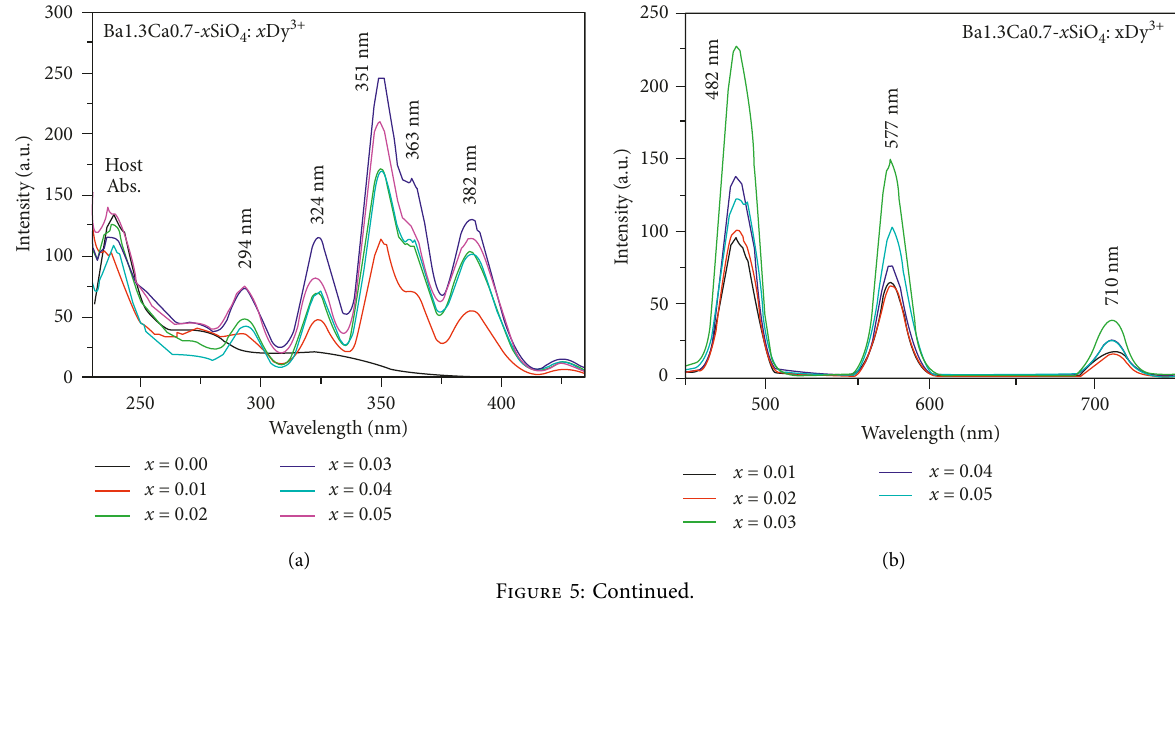
Figure 4: (a) UV-Vis diffuse reflectance spectra for Ba Ba1.3Ca0.7 − xSiO4: x Dy3+ ( x � 0.00, 0.01, 0.02, 0.03, 0.04, and